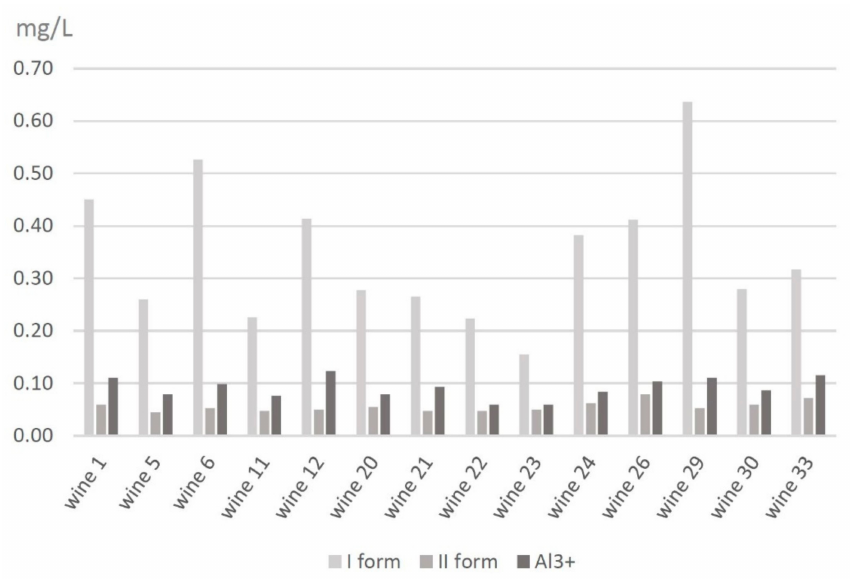
Figure 8. Comparison of the contribution of all forms of aluminum in red